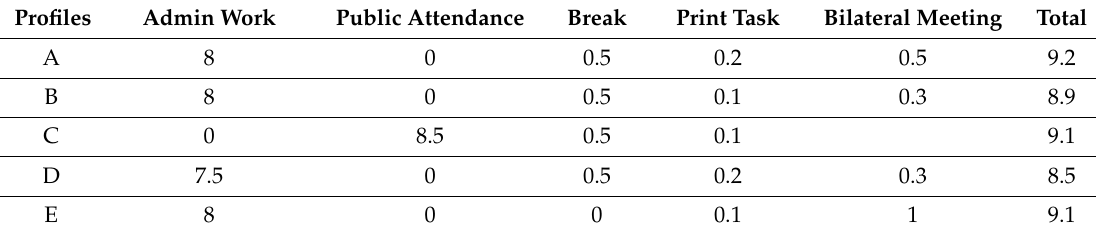
Table 7. Working hours per business process and o ffi ce profile.